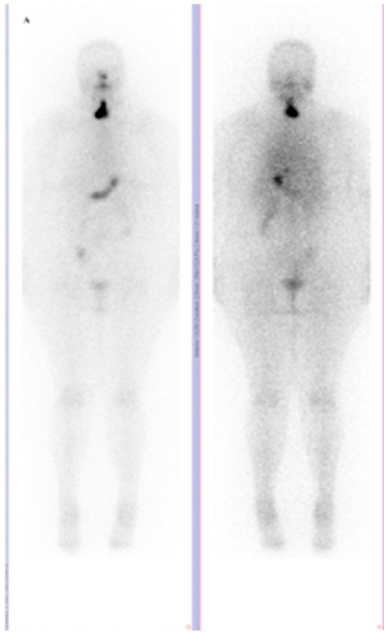
Figure 2. Whole Body Scan with I-131 sodium iodide (I-131 WBS) with 42,36 mCi (1,56 GBq) at 48 h postadministration, with thyroid remnant uptake (anterior left , posterior right ) (2010).